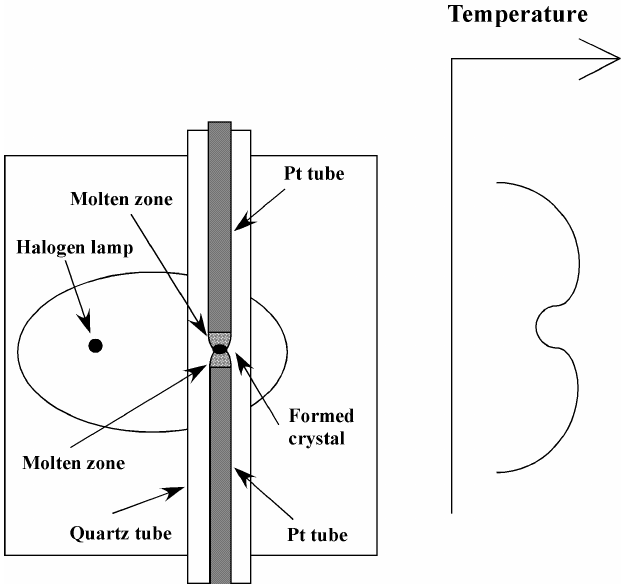
Figure 2. Schematic drawings of the modi fied floating zone (Fz) technique, reprinted with permission from [15]. Copyright 2006